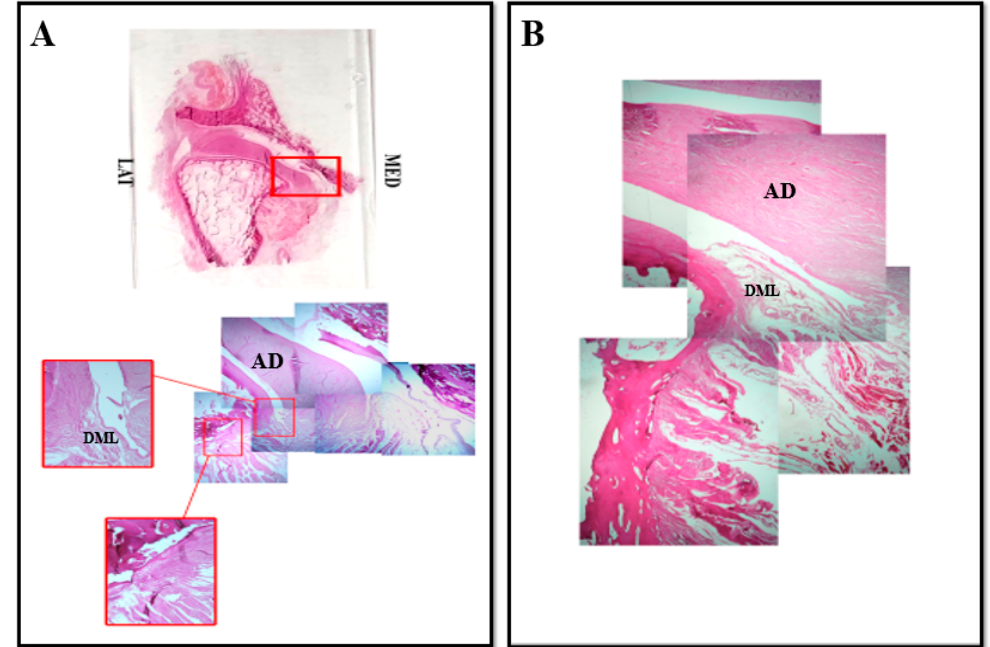
Figure 3. Compound panel of Hematoxylin-Eosin staining of human TMJ, medial side (red box). Sections were reconstructed in order to observe a wide microscopic field at the level of the medial side of TMJ. It is possible to observe the existence of an anatomical structure made up of loose fibers that originate from lateral side of articular disc and insert on articular cartilage of mandibular condyle in the medial side ( A ), DML. In our opinion this structure corresponds to the medial lateral ligament; in ( B ) pictures show the direct insertion of discal lateral ligament on the superficial layer of mandibular condyle cartilage surface. AD: articular disc; DML: discal medial ligament.